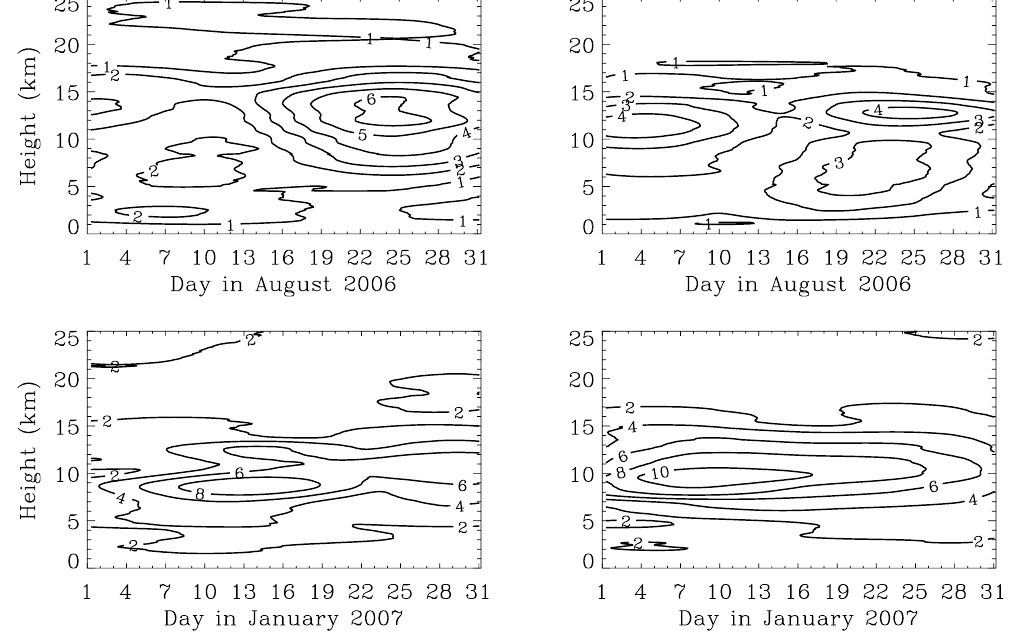
Fig. 11. The QSDPW amplitudes for the zonal wind (left) and meridional wind (right) in August 2006 (upper) and January 2007 (lower) from the wavelet